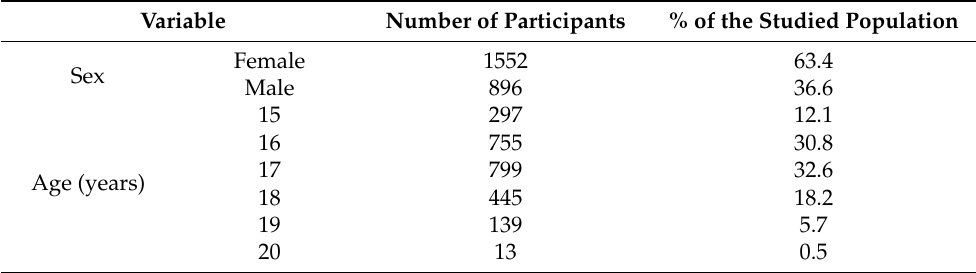
Table 1. The characteristics of the population studied within the second phase of the Polish Adoles- cents’ COVID-19 Experience (PLACE-19) Study ( n =